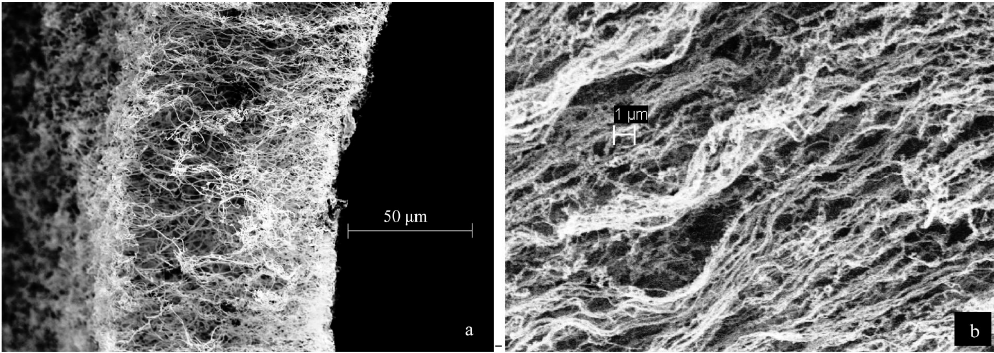
Figure 11. Scanning electron microscopy (SEM) images of lyophilized lignin ribbons, ( a ) Indulin AT nanofibers based on a 0.1% w / w solution, ( b ) Reax 85A lignin nanofibers based on a 0.3% w / w solution. Reprinted with permission from Spender et al. [97]. Copyright 2012 American Chemical Society.